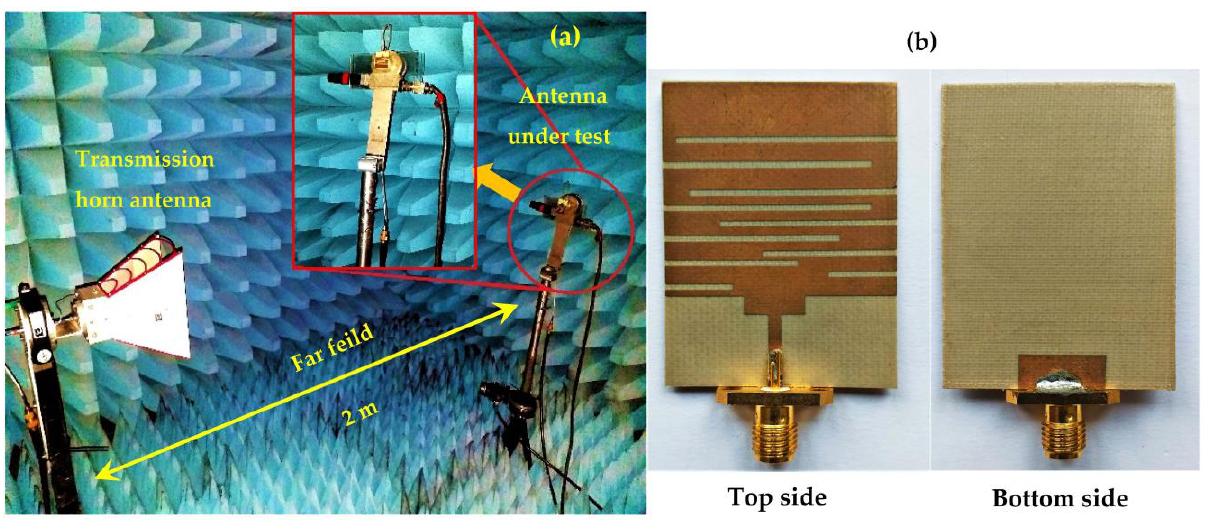
Figure 7 . ( a ) Measurement prototype and ( b ) realized antenna. Figure 7. ( a ) Measurement prototype and ( b ) realized